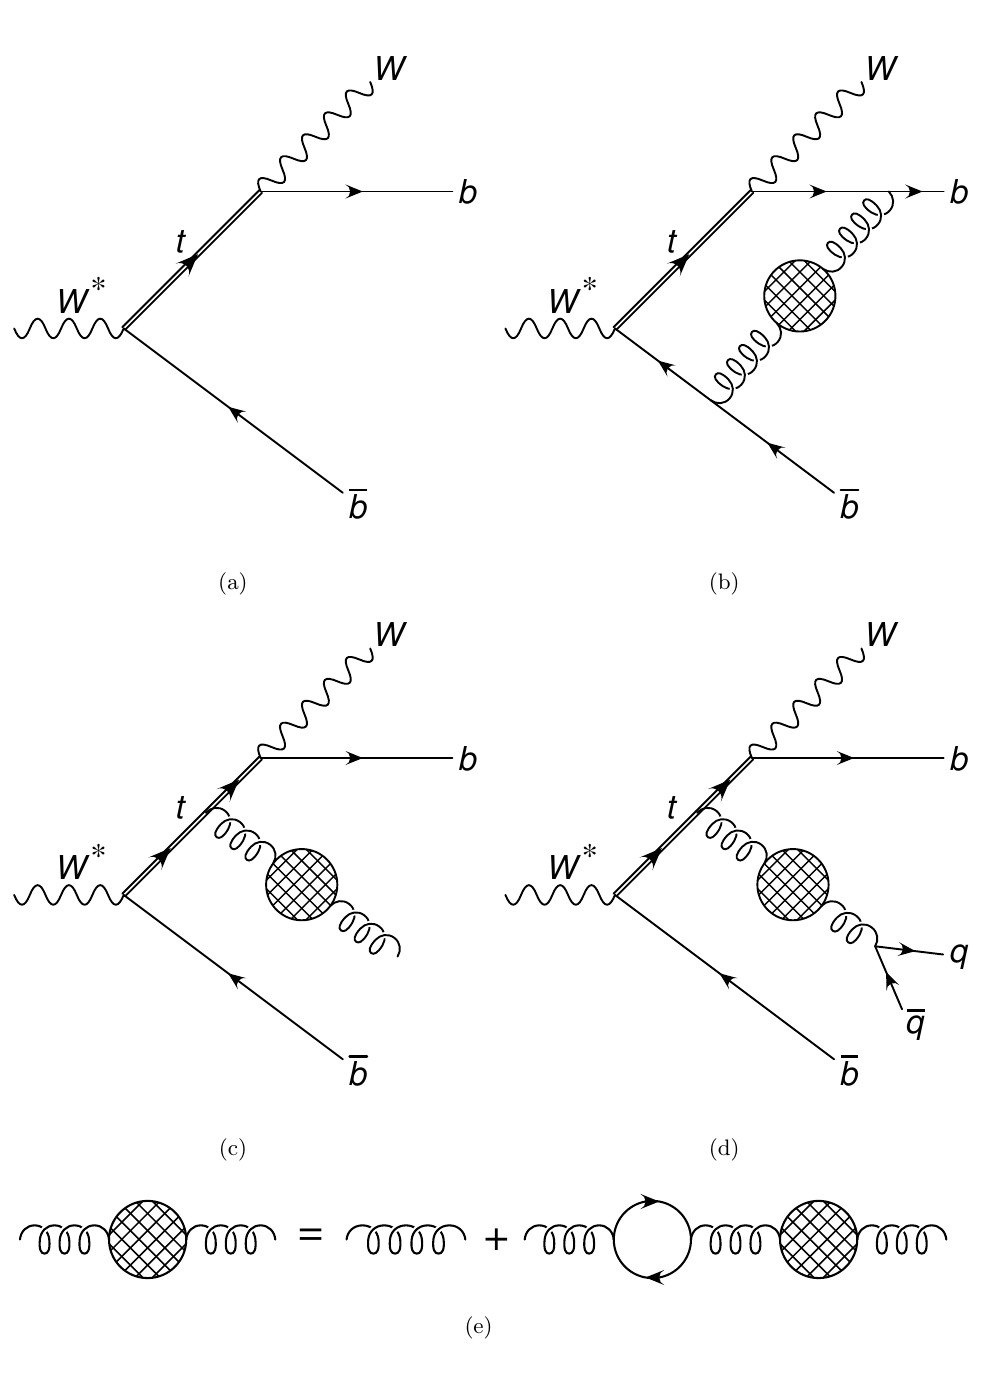
Figure 1 . Feynman diagram for the Born W (cid:3) ! Wb (cid:22) b process (a), and samples of Feynman diagrams for the virtual contribution (b), for the real-emission contribution (c) and for W (cid:3) ! Wb (cid:22) b q (cid:22) q production (d).